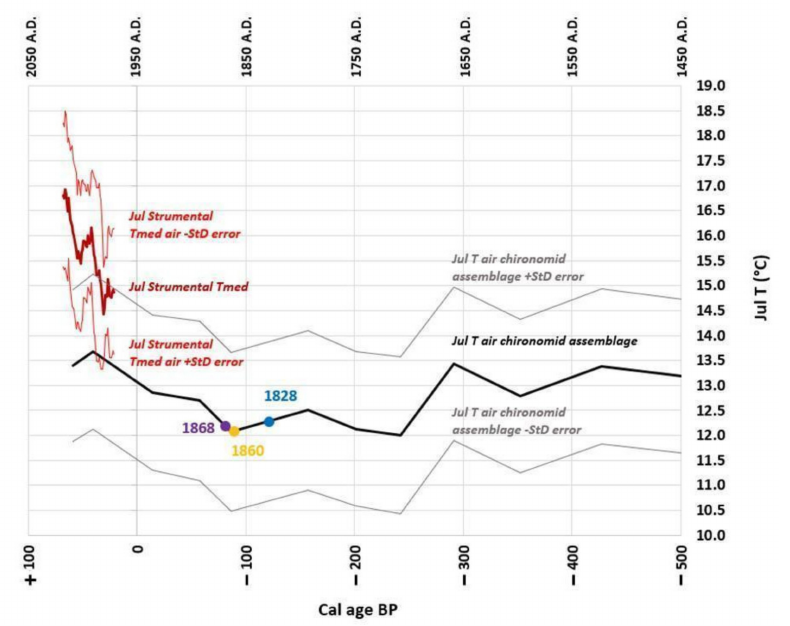
Figure 10. The black line shows the reconstructed temperature, while the gray lines are the sample- specific estimated standard error associated with the temperature reconstruction based on chironomid assemblages from [24]. The dark red line represents the July mean temperature (1971–2018) retrieved for the Verdarolo meteorological station of ARPAe-SIMC network Emilia-Romagna Region (11-year running average). The light red lines are standard deviation